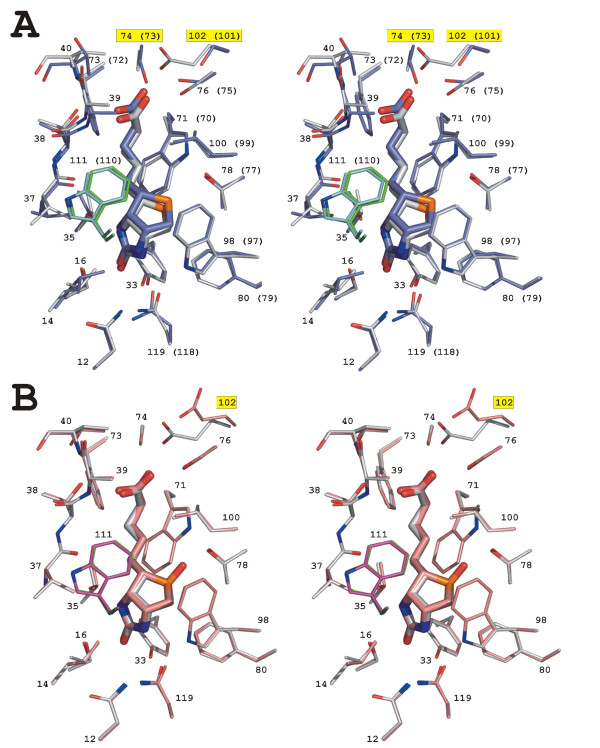
The binding mode of BTN and BSO. (a) BTN (thick sticks) and the amino acids within 4 Å of BTN in the BBP-A – BTN and AVD [PDB: 2AVI] structures are shown. The carbon atoms of residues from subunit 1 of the BBP-A and AVD structures are coloured light grey and blue, respectively. The carbon atoms of Trp111 (Trp110) from subunit 2 of BBP-A (AVD) are coloured green (cyan). The amino acids of BBP-A (AVD) are numbered. The labels of the non-conserved residues are indicated with a yellow background. (b) BTN and BSO (thick sticks), and the amino acids within 4 Å of the ligands in the BBP-A – BTN and BBP-A – BSO structures are shown. The carbon atoms of residues from subunits 1 of the BBP-A – BTN and BBP-A – BSO structures are coloured light grey and light red, respectively. The carbon atoms of Trp111 from subunit 2 of the BBP-A – BTN and BBP-A – BSO structure are coloured green and dark red, respectively. The amino acids are numbered. Glu102, whose side chain has a different conformation in the BBP-A – BTN and BBP-A – BSO structures, is labelled with a yellow background.